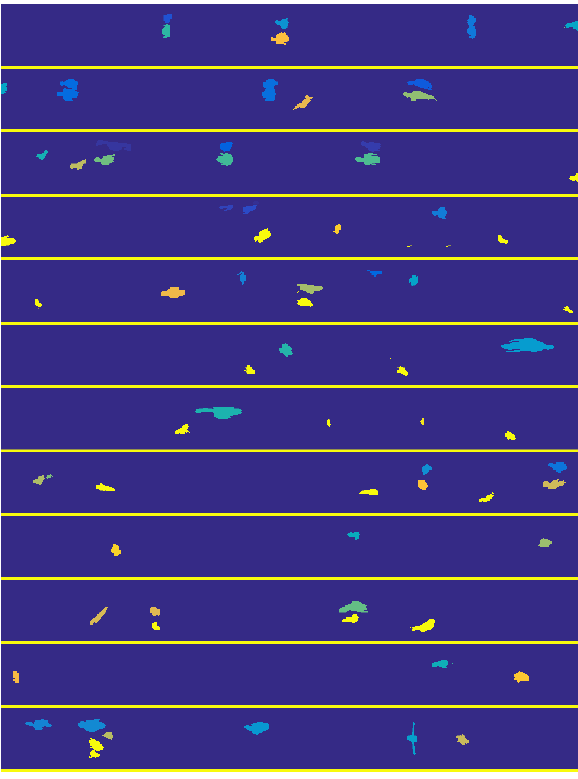
Figure 5. Time series of sparse traffic of the corridor profile scan-